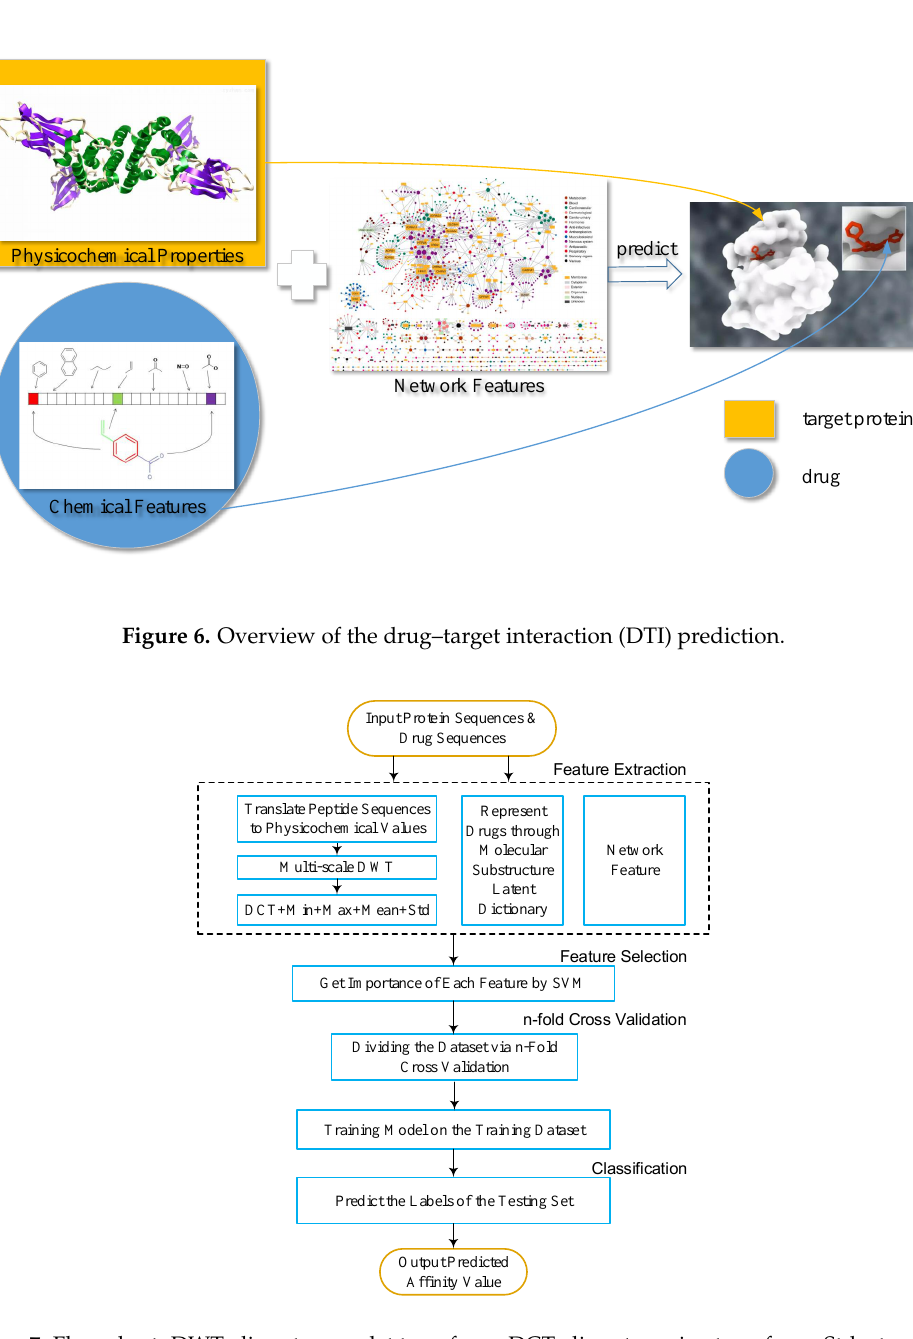
Figure 7. Flow chart. DWT: discrete wavelet transform; DCT: discrete cosine transform; Std: standard deviation; SVM: support vector